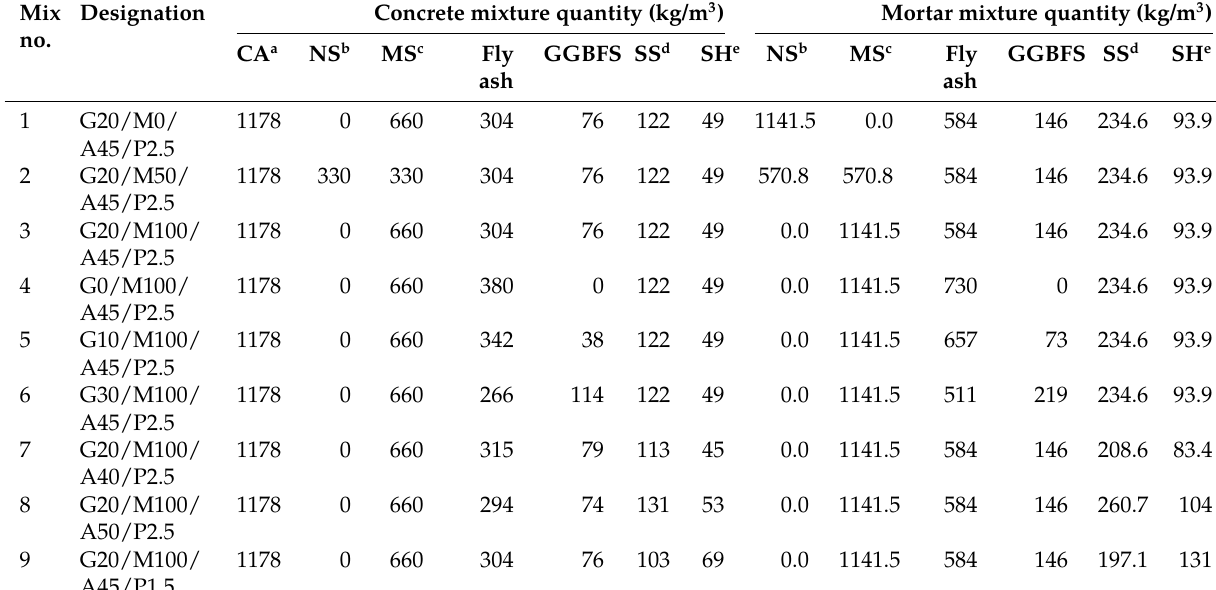
Table 5: Details of mix proportions of geopolymer concrete and mortar (kg/m 3